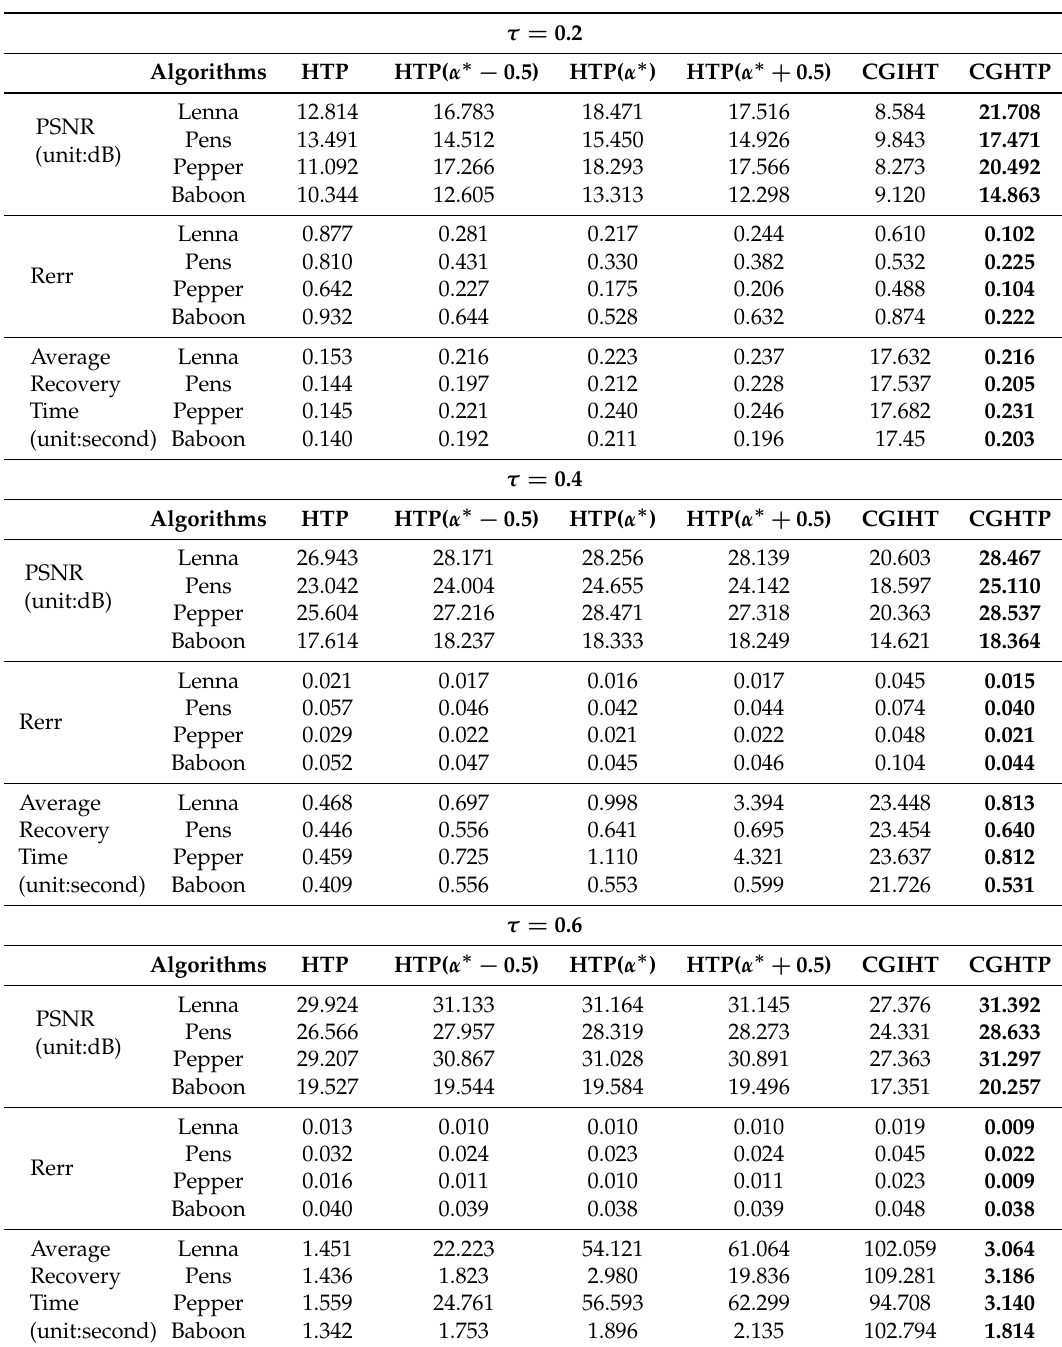
Table 1. Reconstruction results of Lenna, Pens, Pepper, and Baboon images at different sampling rates by HTP, CGIHT, and CGHTP. The optimal step size α ∗ for reconstructing Lenna, Pens, Pepper and Baboon images by HTP algorithm are α ∗ = 5.5, α ∗ = 5, α ∗ = 6 and α ∗ = 4, respectively. The abbreviations PSNR and Rerr in the table represent the Peak Signal to Noise Ratio and relative reconstruction error of the reconstructed image,